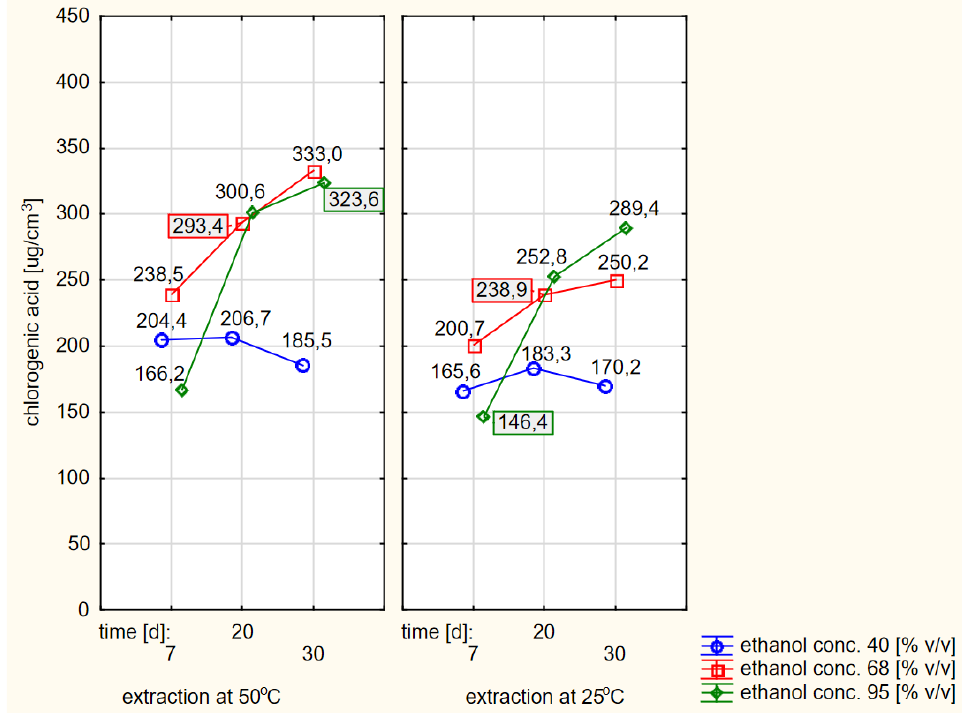
Figure 10. Profiles of chlorogenic acid values in ethanol extracts for the dried raw material obtained from previously frozen elderberry flowers, presented separately for the hot and cold extraction var- iants.